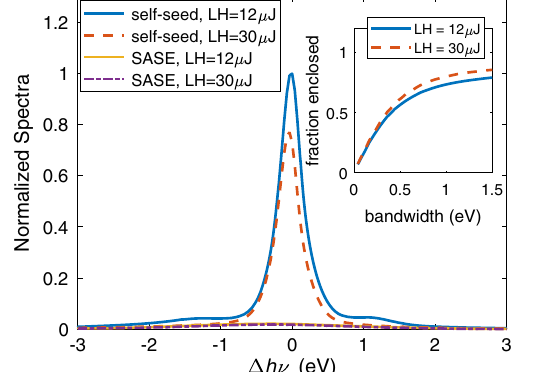
FIG. 12. Average spectra of the self-seeding and SASE output at U15 under different LH pulse energies. The inserted figure shows the fractional spectral energy as a function of integrated bandwidth.